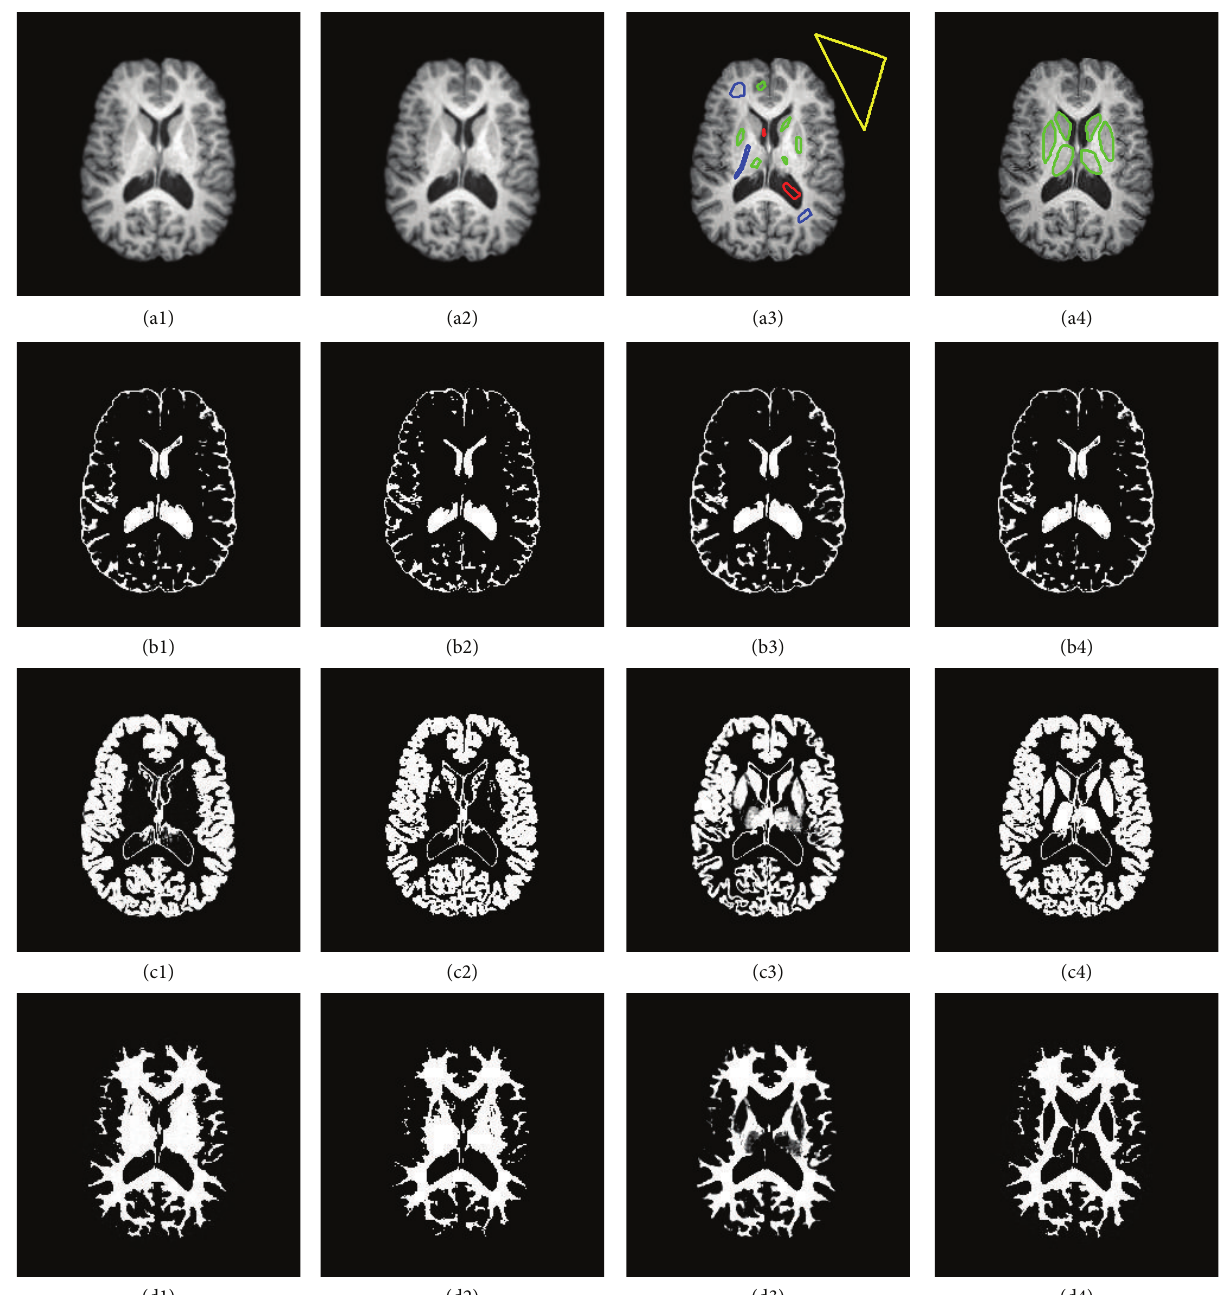
Figure 9: Comparison among unsupervised soft Mumford-Shah model, Mumford-Shah model with bias correction, supervised Mumford- Shah model, and the ground